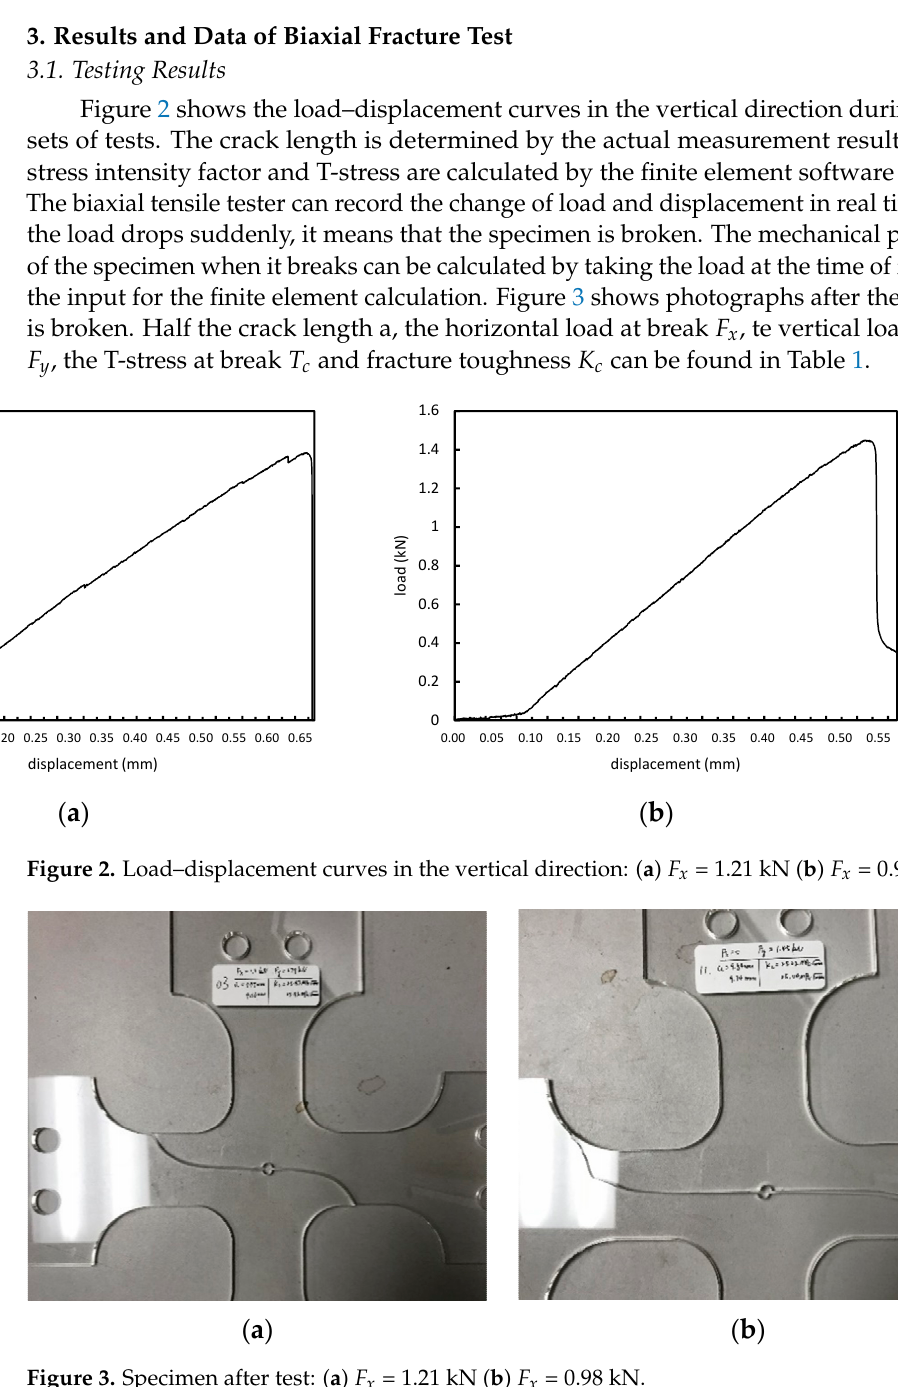
Figure 3. Specimen after test: ( a ) F x = 1.21 kN ( b ) F x = 0.98 kN. Table 1. a , (cid:1832) (cid:3051) , (cid:1832) (cid:3052) , (cid:1846) (cid:3030) , (cid:1837) (cid:3030) values in cross-shaped specimen